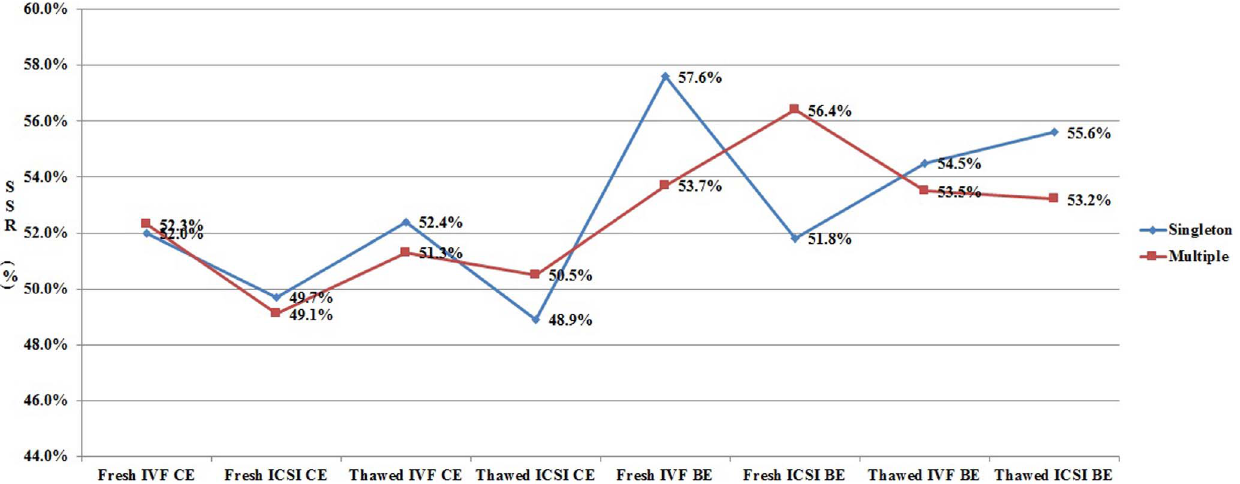
Figure 4. Effect of type of birth (singleton/multiple delivery) on SSR. SSR= secondary sex ratio; IVF= in vitro fertilization; ICSI= intracytoplasmic sperm injection; CE= cleavage stage embryo; BE= blastocyst embryo.